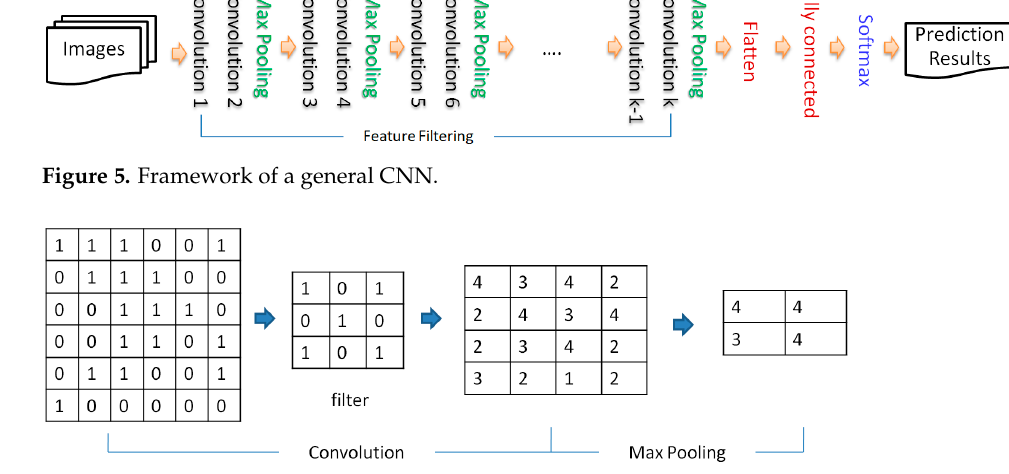
Figure 6. Examples of Convolution and max-pooling.